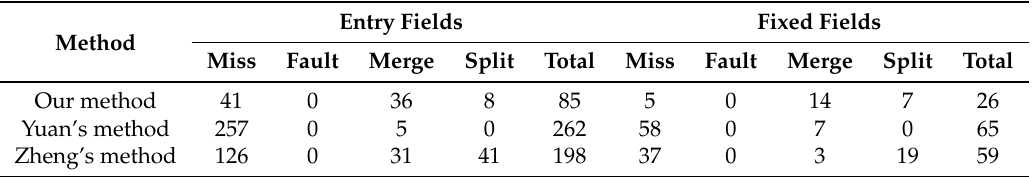
Table 4. Numbers of every Error types in obvious case of